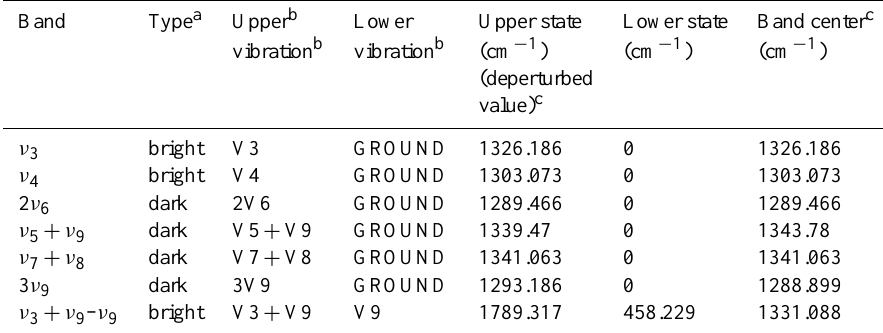
Table 1. HNO 3 vibrational states involved in the 7.6µm region.